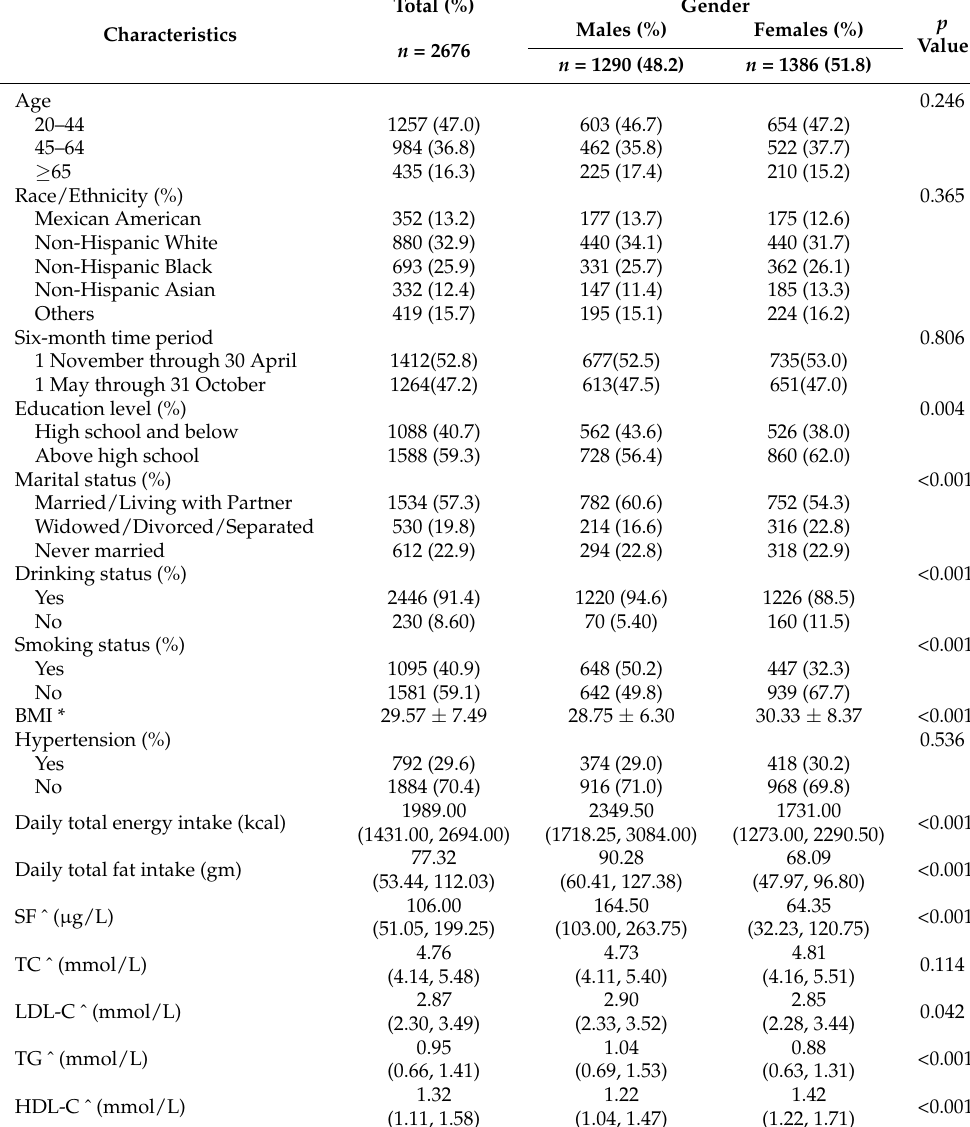
Table 1. Baseline characteristics of the subjects according to